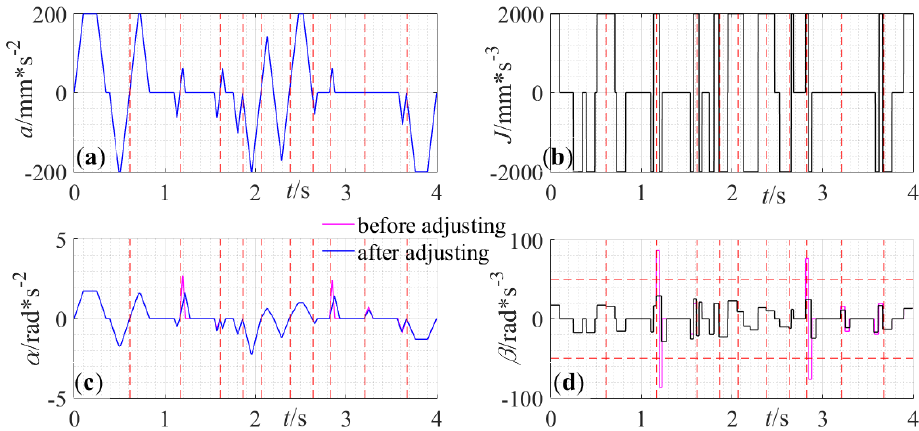
Figure 14. Tangential kinematic profiles—( a ) Tool-tip position acceleration. ( b ) Tool-tip position jerk. ( c ) tool orientation acceleration. ( d ) tool orientation jerk.